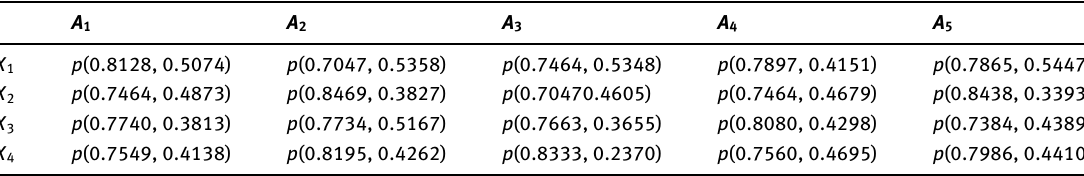
Table 8: Collective Pythagorean Fuzzy Decision